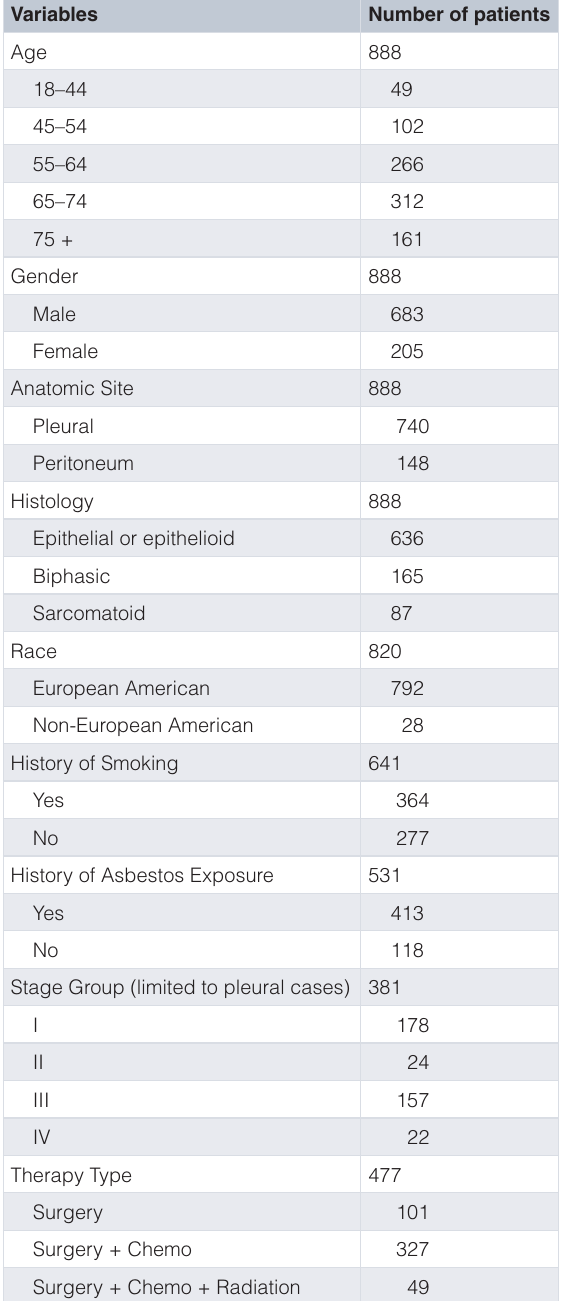
Table 1. Patient